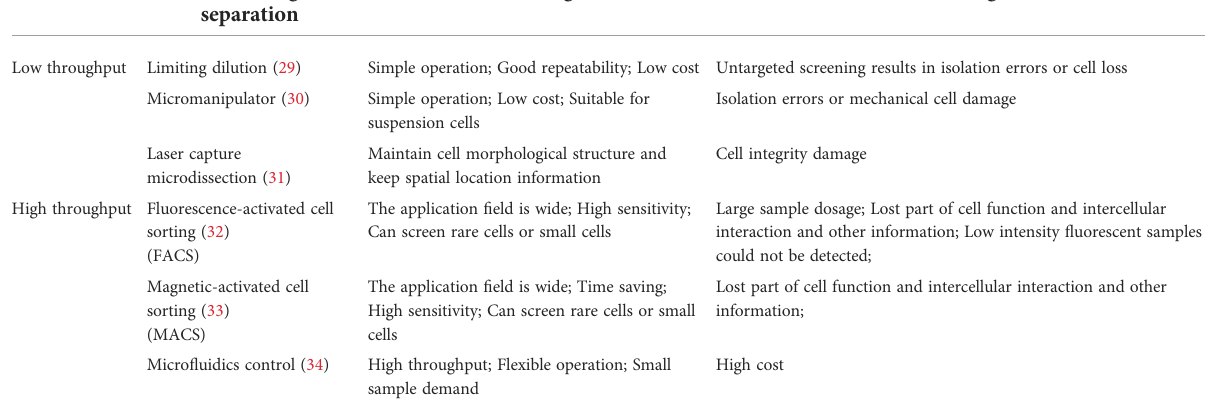
TABLE 1 List of single cell preparation methods. Method for single cell